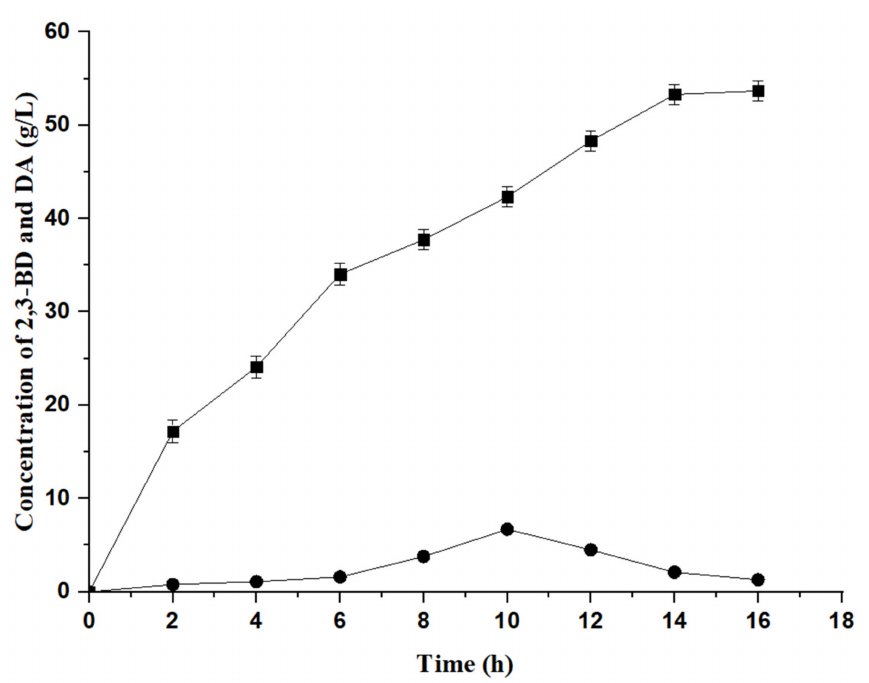
Figure 6. Time course of fed-batch bioconversion by Serratia marcescens MG1ABC (pSWNB+pETDuet- bdhA-fdh). Circular represents acetoin. Square represents